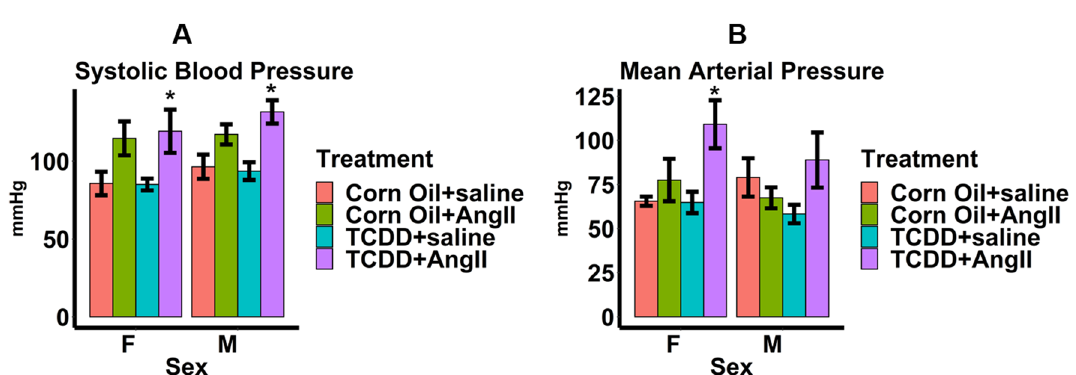
Figure 5. Blood pressure measurements taken two weeks after angiotensin II infusion in male and female 14-month-old mice. Systolic blood pressure ( A ) and mean arterial pressure ( B ) were measured. Values are mean + SE. * p < 0.05 using Welch two-sided t-test comparing saline to Ang II by each sex and either corn oil or TCDD. # p < 0.05 using Welch two-sided t-test comparing TCDD to corn oil by each sex and either saline or Ang II. Corn oil + Ang II: n = 6 females, 7 males; Corn oil + saline: n = 4 females, 4 males; TCDD + Ang II: n = 7 females, 7 males; TCDD + saline: n = 6 females, 7